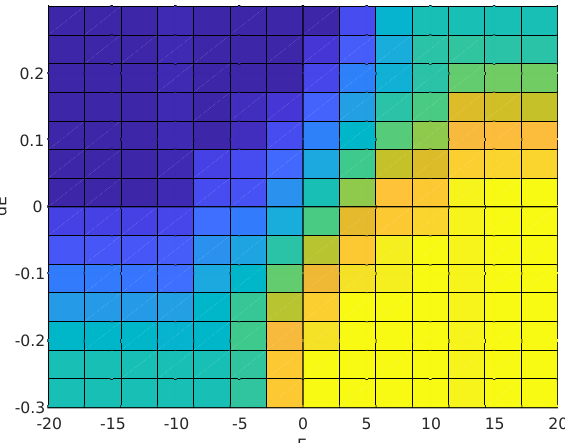
Figure 8. Upper view of the relationship between the inputs: Error variation ( dE ) and error ( E ); and the output: voltage variation ( dV